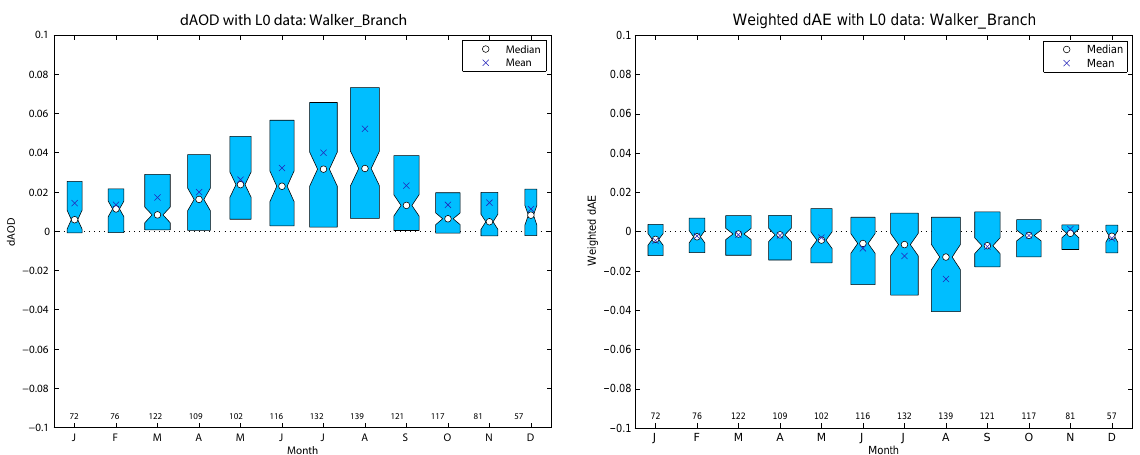
Weighted dAE with L0 data: Walker_Branch